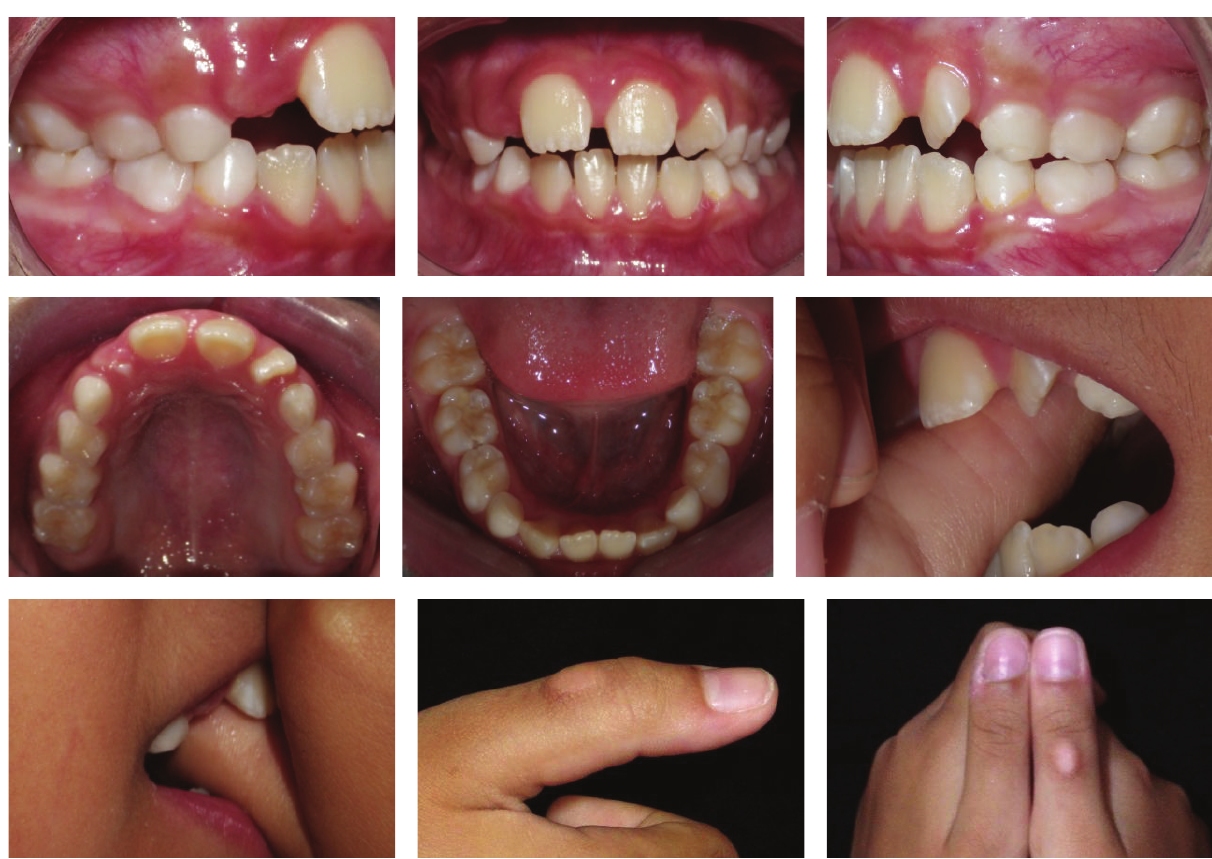
Figure 6: 18 months after removal of palatal expander appliance. Relapse of the anterior open bite due to relapse of the thumb sucking habit. Callus on the right thumb